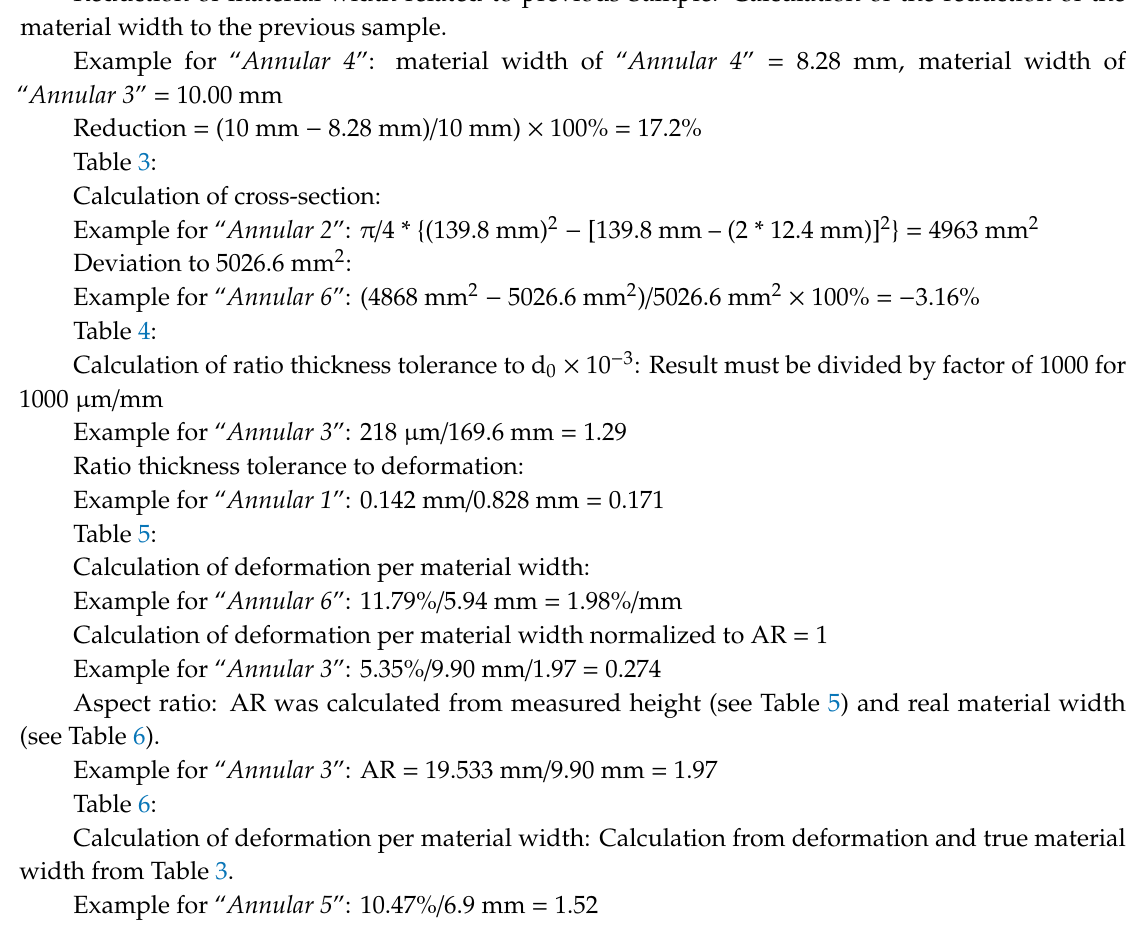
− 3 : Result must be divided by factor of 1000 for